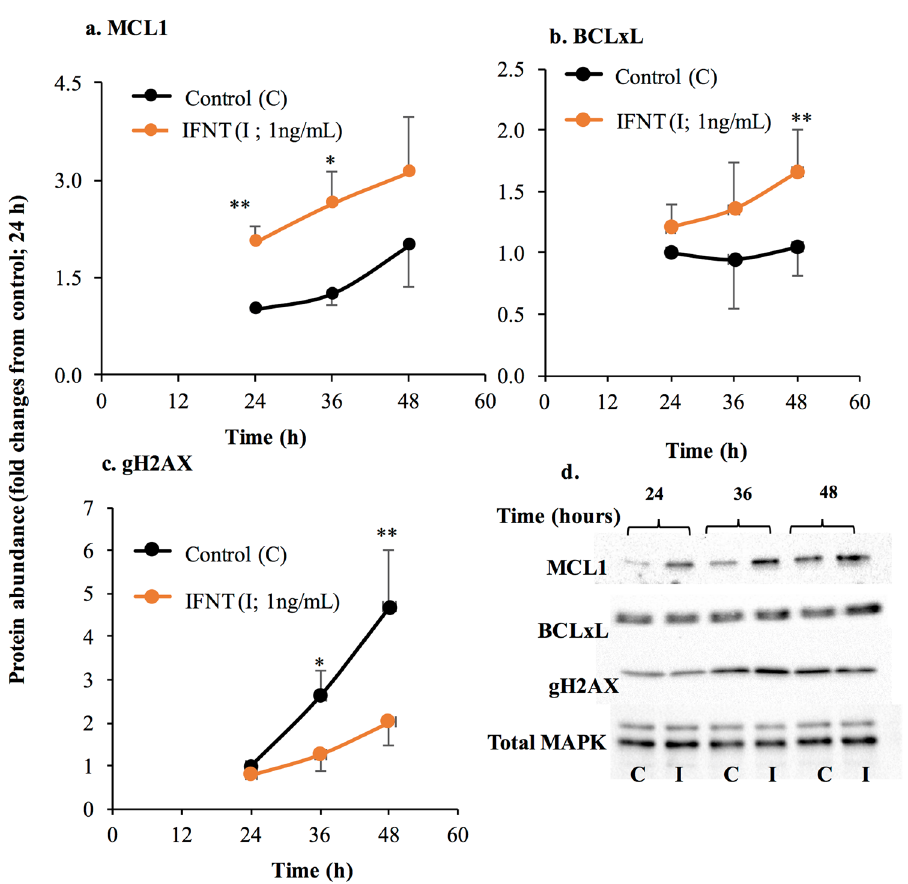
Figure 4. Time-dependent effects of IFNT on pro- and antiapoptotic proteins. LGCs were incubated without (control) or with roIFNT (1 ng/mL) for 48 h, ( a ) MCL1, ( b ) BCL-xL, and ( c ) gH2AX protein levels were determined in cell extracts by western blotting and normalized relative to the abundance of total MAPK (p44/42). All blots expect MCL1 were cropped from different parts of the same gels. Results are presented as the means ± SEM from four independent experiments. ( d ) Representative images of the western blots for each antibody. Asterisks indicate significant differences from their respective controls ( * P < 0.05, ** P < 0.01, *** P <